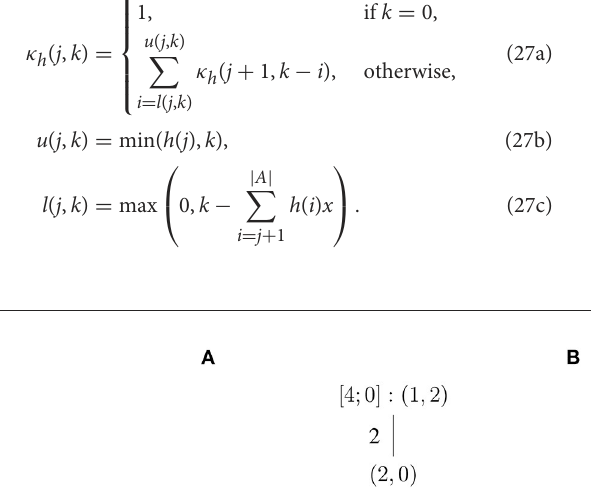
FrontiersinComputerScience